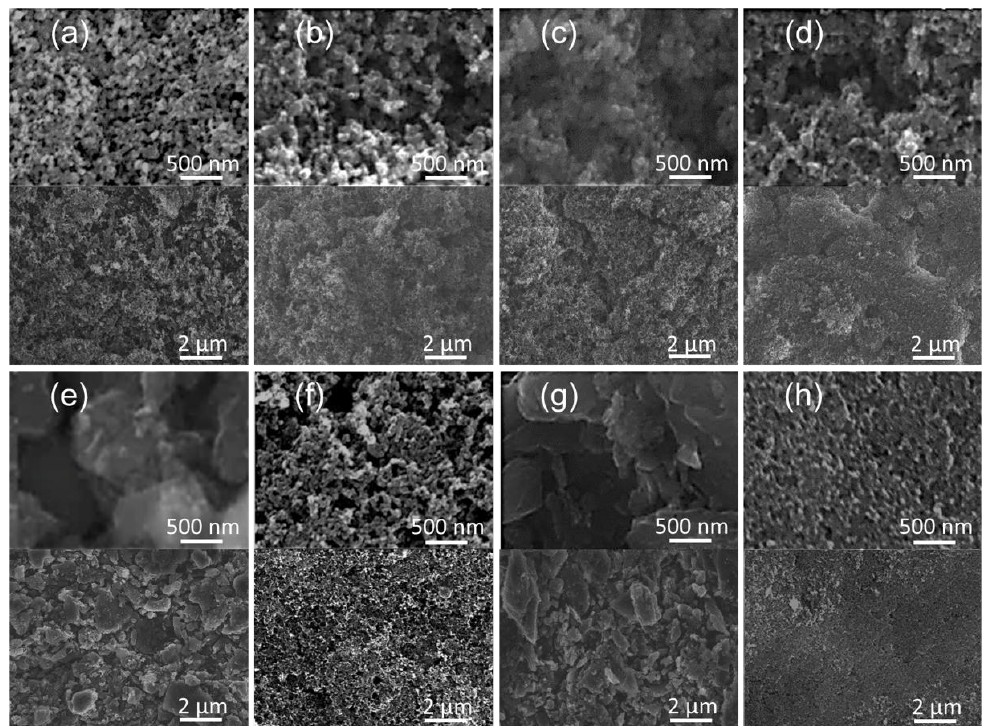
Figure 1. Material characteristics: ( a,b ) nitrogen adsorption/desorption isotherms and ( c,d ) pore- size distributions of various carbon materials for the carbon-coated separators.